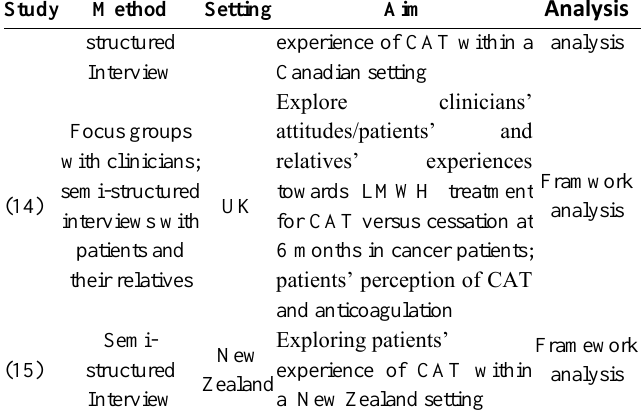
Figure 1 : Study selection process of scoping review All titles and abstracts from the search were evaluated independently by two reviewers (AI and RM) and disagreements were resolved by a third arbitrator (AY). In total, ten qualitative studies discussing thrombosis and anti-thrombotic treatment in cancer patients were found. However, no studies explored patients' understanding of VTE in prophylactic settings in high-risk cancer patients.